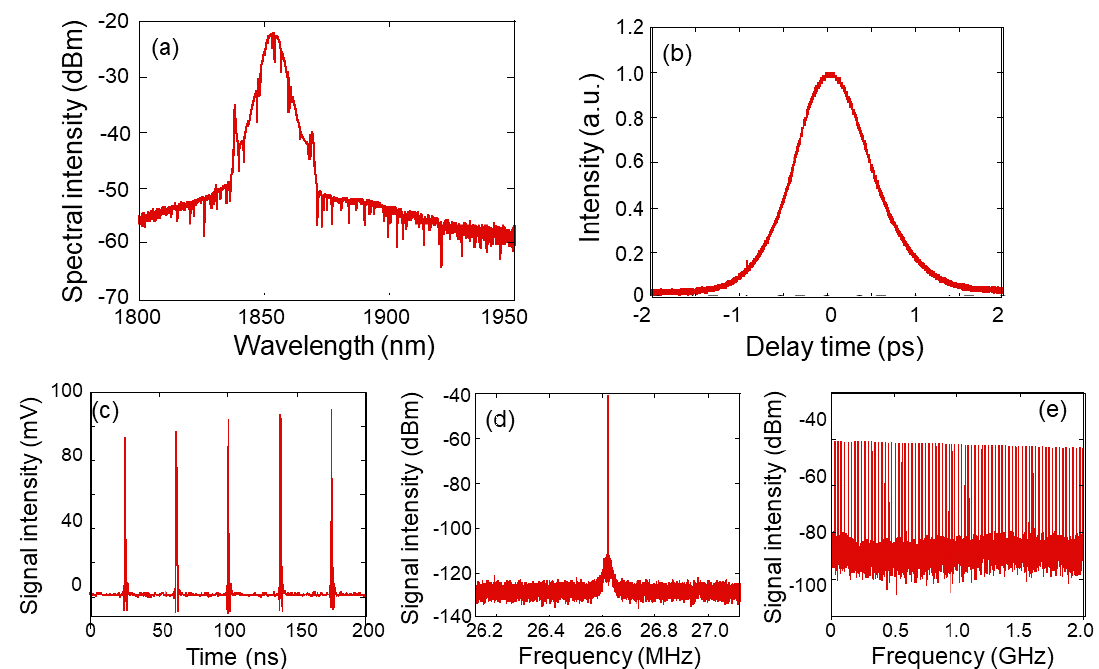
Figure 6. Characteristics of output pulses when D = − 0.144 ps 2 and spectral filter was used, ( a ) optical spectra, ( b ) autocorrelation trace, ( c ) pulse train, ( d , e ) RF spectra of ( d ) fundamental frequency and ( e ) wide range.